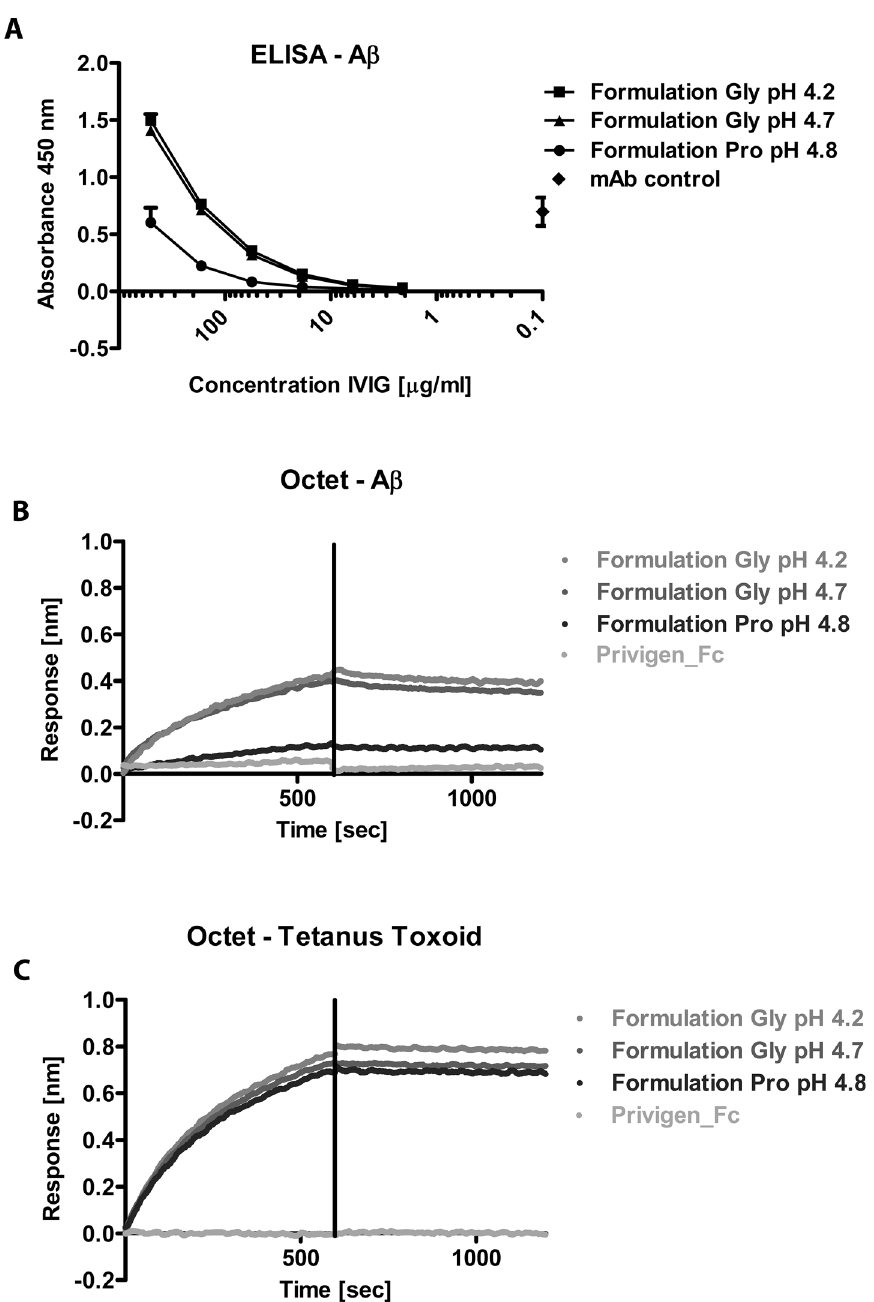
Fig 3. In vitro Comparison of reformulated IgG preparations activity to A β , actin and tetanus toxoid by ELISA and Octet. Unformulated Privigen (in H 2 O) was formulated in Proline pH 4.8, Glycine pH 4.7 or Glycine pH 4.2. (A) ELISA measurements on plate-bound A β oligomers. The panel shows combined results from repeated measurements (n = 3). (B) Octet binding measurements to immobilized A β and C to bound tetanus toxoid. Privigen Fc fragments were used as negative